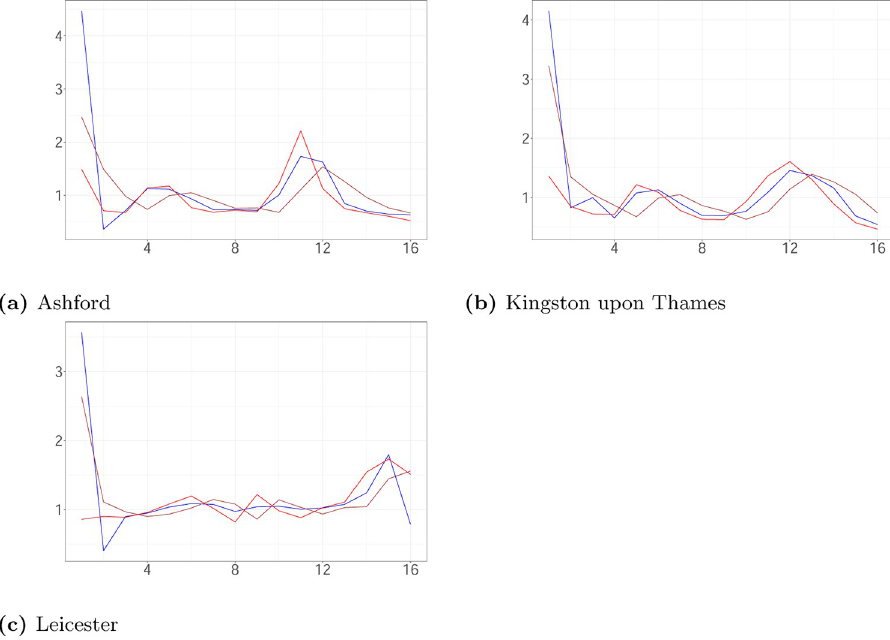
Fig 11. The weekly average of daily estimates of the reproduction number via posterior median derived by the method of Koyama et al. [10] (blue line) and the posterior medians of R(t) given by EpiEstim (brown line) and the proposed algorithm (red line) plotted against time. (a) Ashford. (b) Kingston upon Thames. (c)